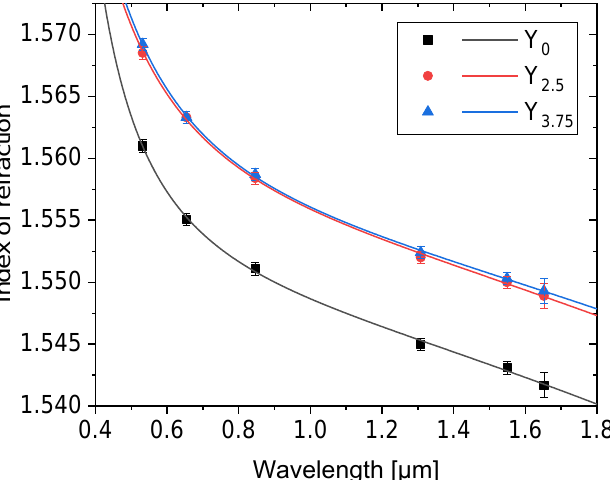
Figure 6. The IR spectrum of the investigated glasses. The results are shown in Figure 7 and the calculated Sellmeier coefficients are in